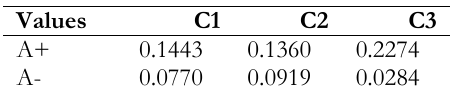
Table 25. The values of the positive and negative ideal solution.